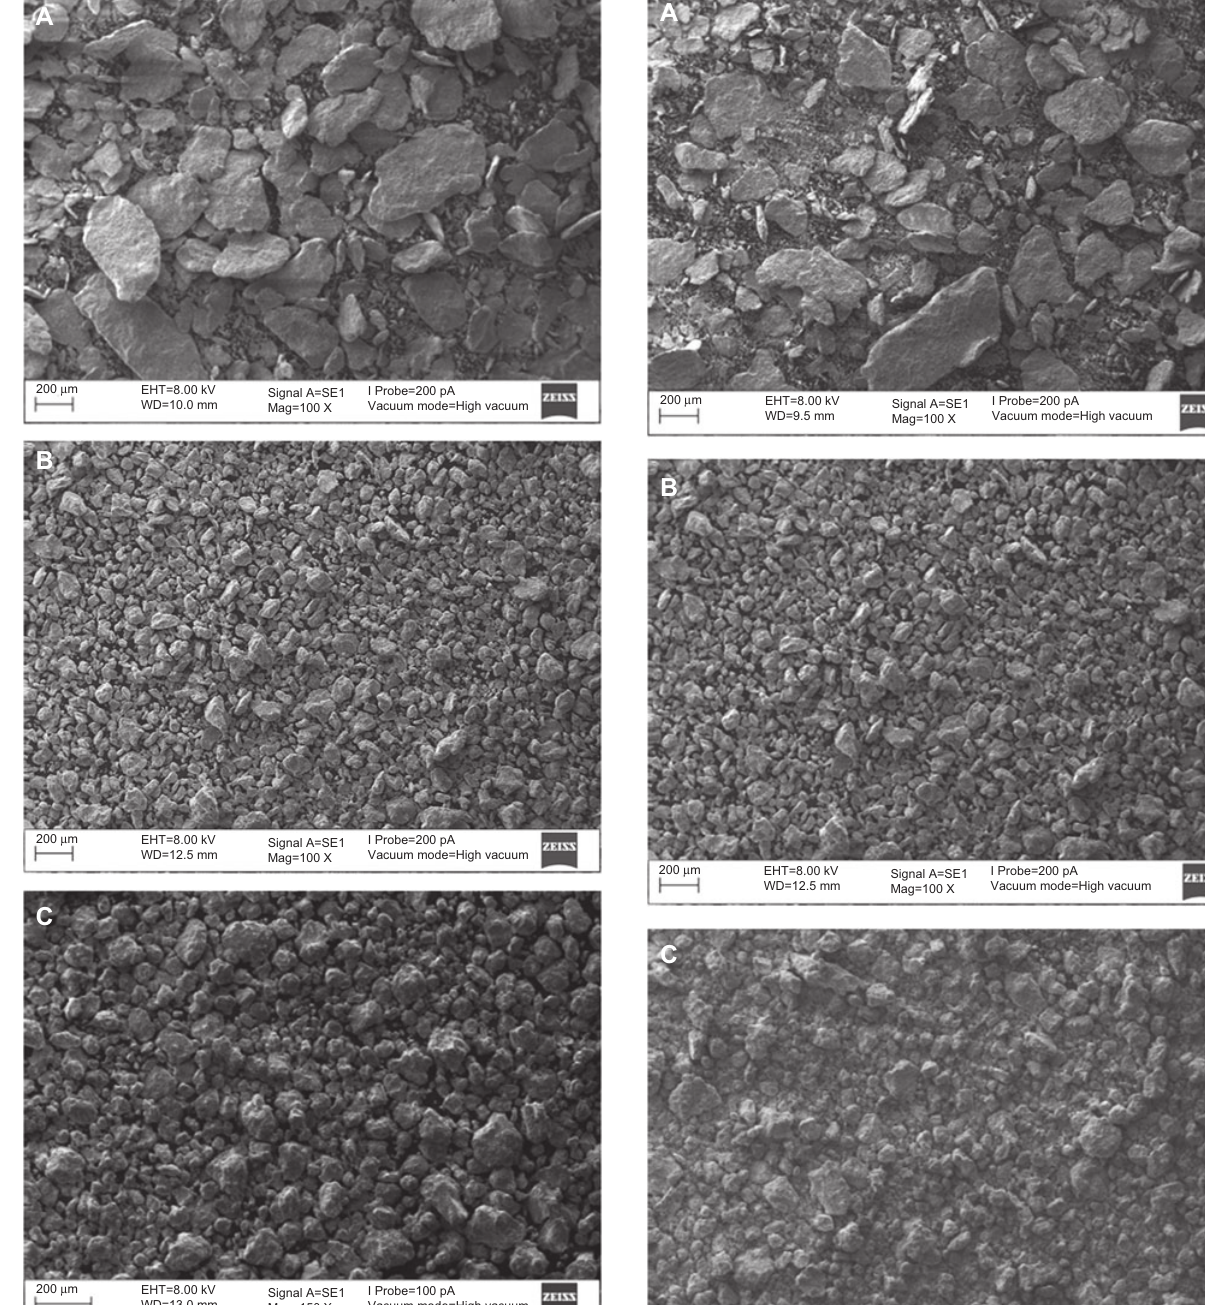
O composite powder as a 2 3